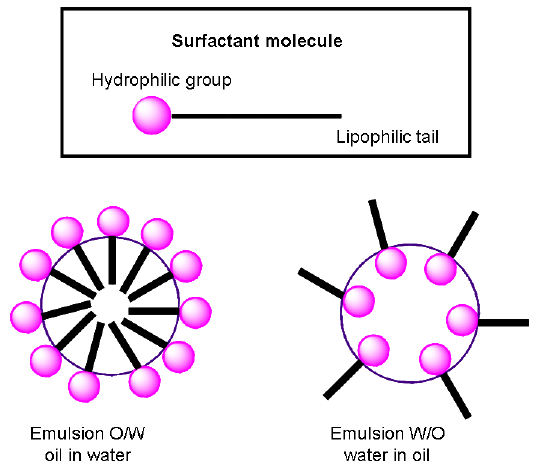
Figure 3. A potent drug carrier vehicle: lipid